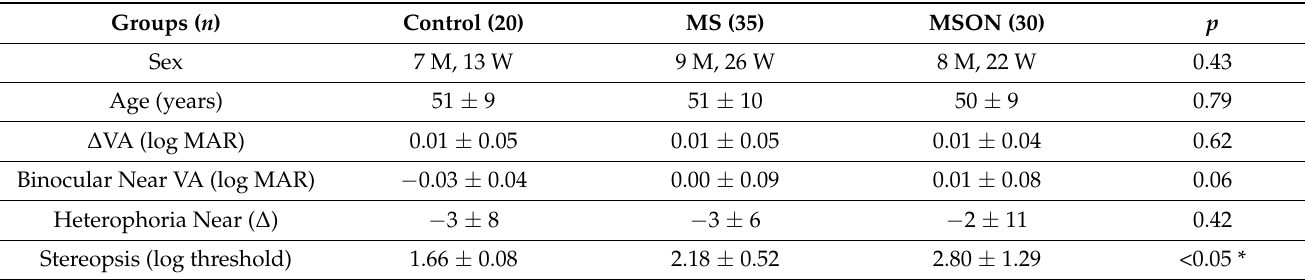
Table 1. Clinical and demographic characteristics of the three study groups. Mean ± standard deviation (minimum–maximum) were reported. M = men; W = women. VA difference between eyes ( ∆ VA) and binocular VA for near vision were represented in log MAR. Negative sign (-) of heterophoria represent exophoria. The logarithm value of the stereopsis threshold was presented. Statistically significant differences were marked with an asterisk (*).